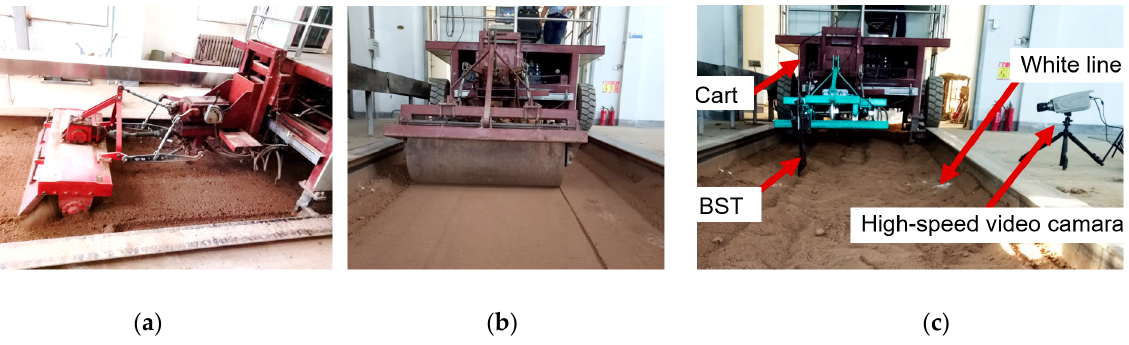
Figure 2. Laboratory soil bin test: ( a ) Rotary tillage; ( b ) Soil compaction; ( c ) Equipment for subsoiling test.